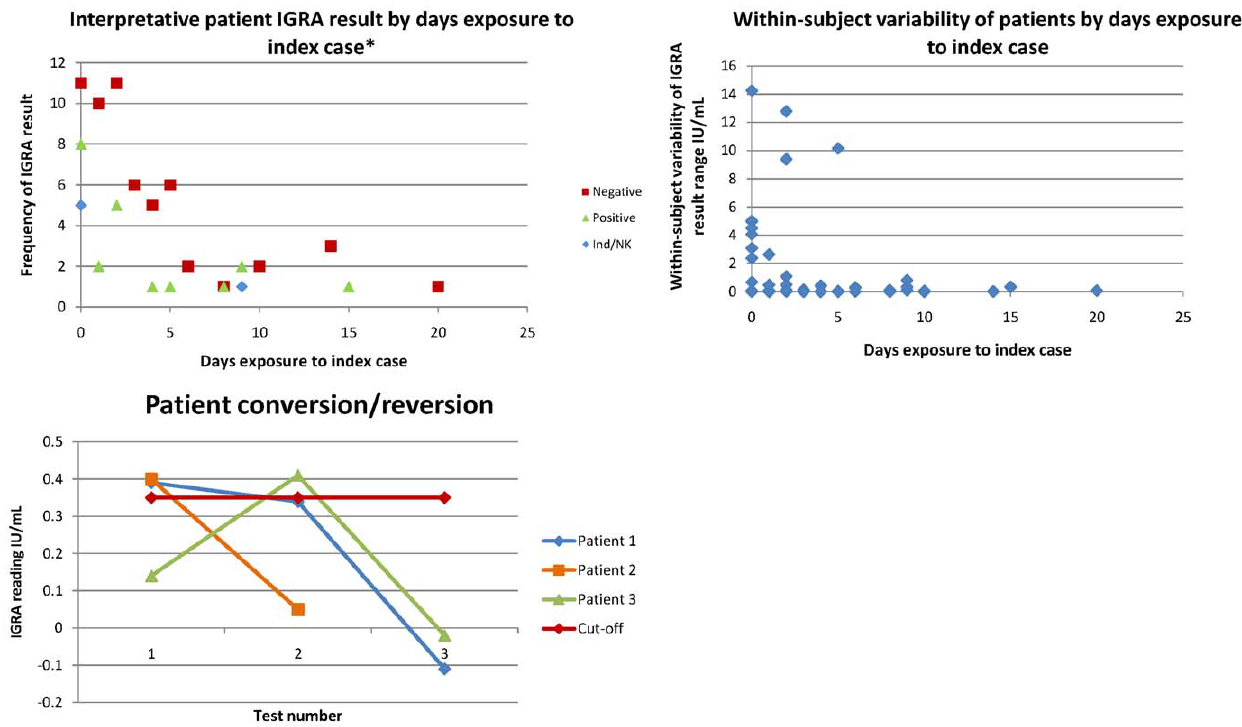
Figure 2. Study IGRA results. A, Interpretative patient IGRA result by days exposure to index case. *Serially IGRA-tested patients only. B, Within- subject variability of patients by days exposure to index case. C, Patient conversion/reversion.